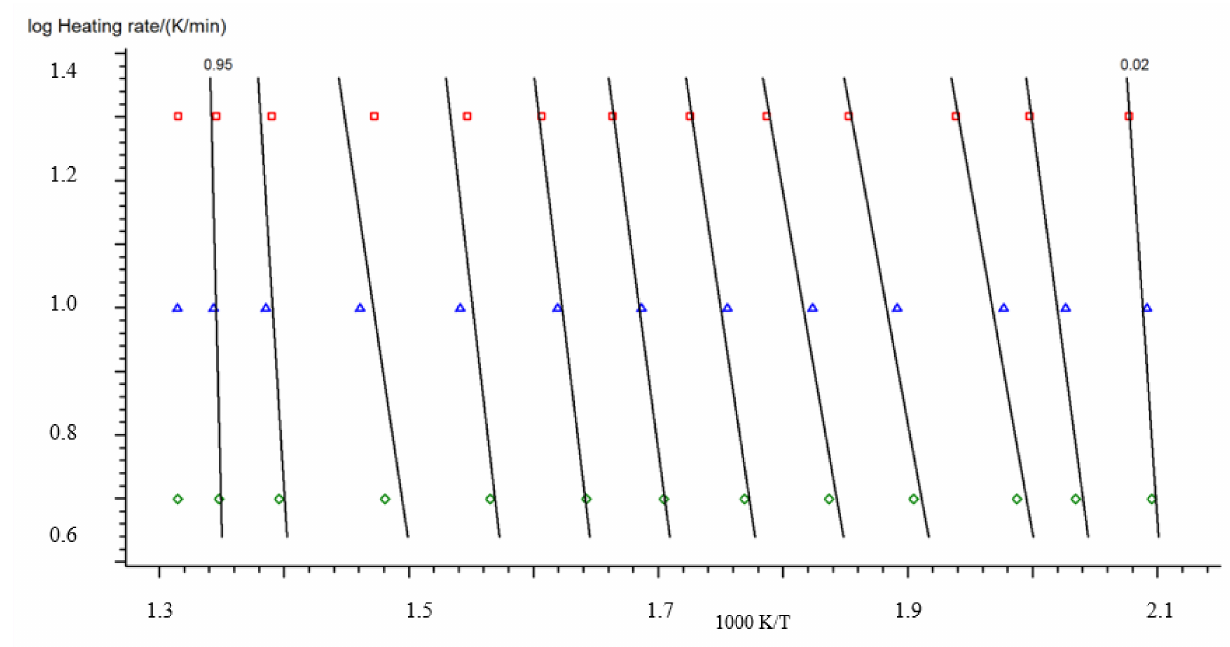
Figure 12. Plot of logarithm dx/dt as a function of the reciprocal of temperature for the Ozawa–Flynn–Wall method for sewage sludge. Red: 20K/min, Blue: 10 K/min and Green: 5 K/min.